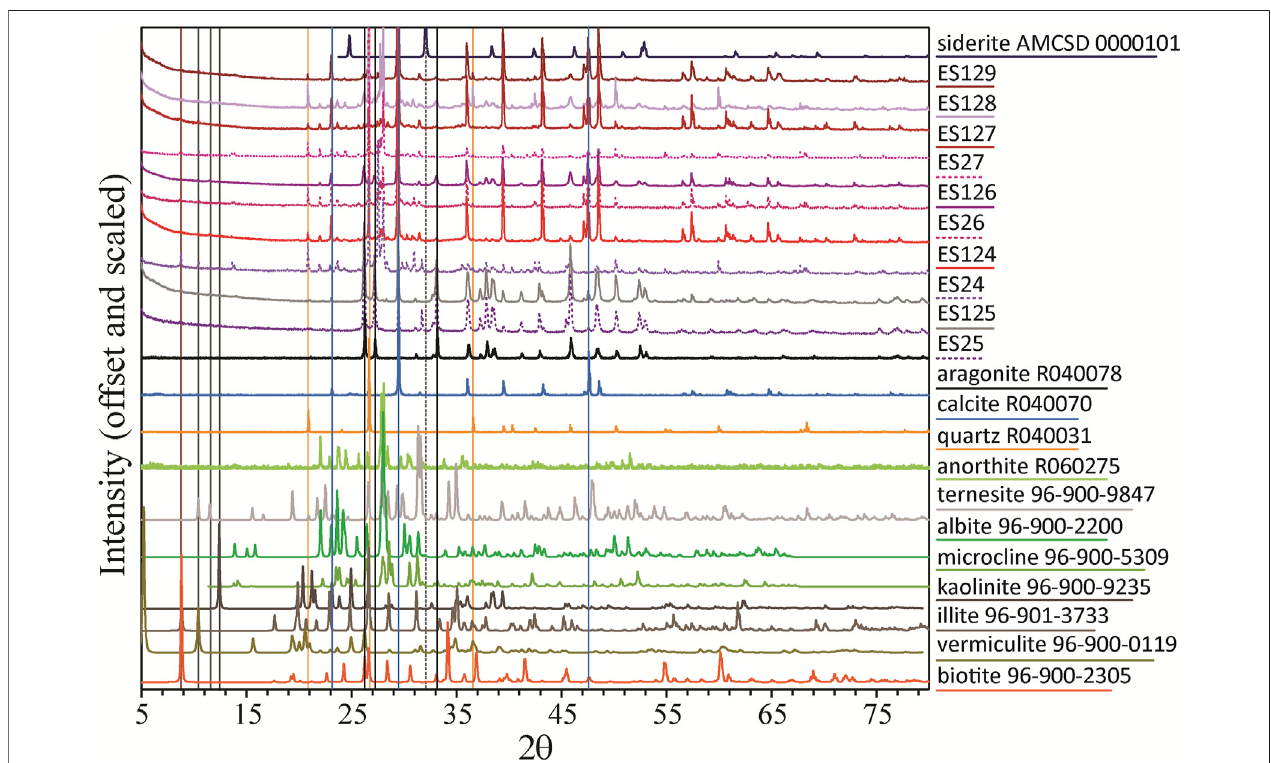
FIGURE 2 | XRD patterns of Blood Falls colored sediments, reference spectra for phases identi fi ed by the RSL2 “ high ” and “ low ” baseline fi tting results along with phases inferred from local mineralogy and identi fi able peaks (e.g., phyllosilicates and clays). Reference patterns with R* numbers are from the RRUFF (Lafuente et al., 2015) database 1 , with 96- numbering from free COD library, and with “ AMCSD ” from the American Mineralogist Crystal Structure Database 2